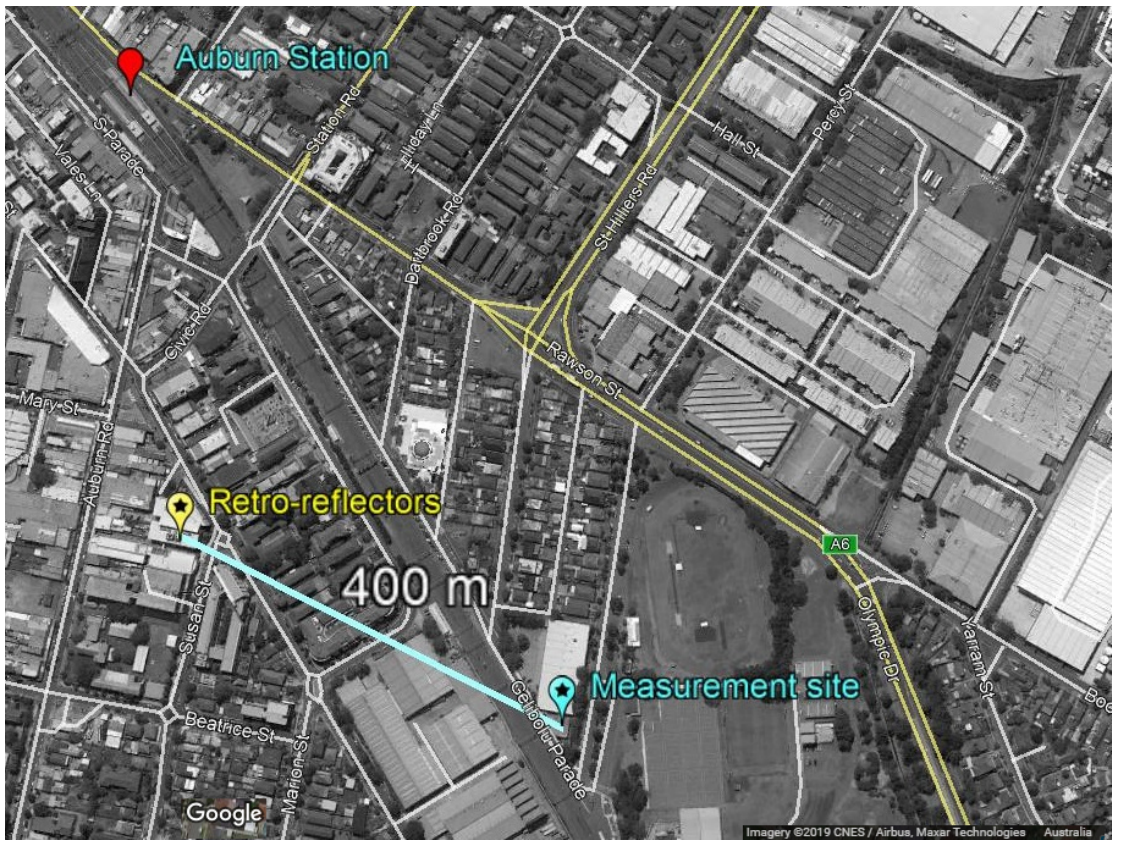
Figure 1. Locations over map (Source: Google Earth) of the Auburn measurement site, the retro-reflectors for the open-paths (400 m) and the Auburn train station for geographic